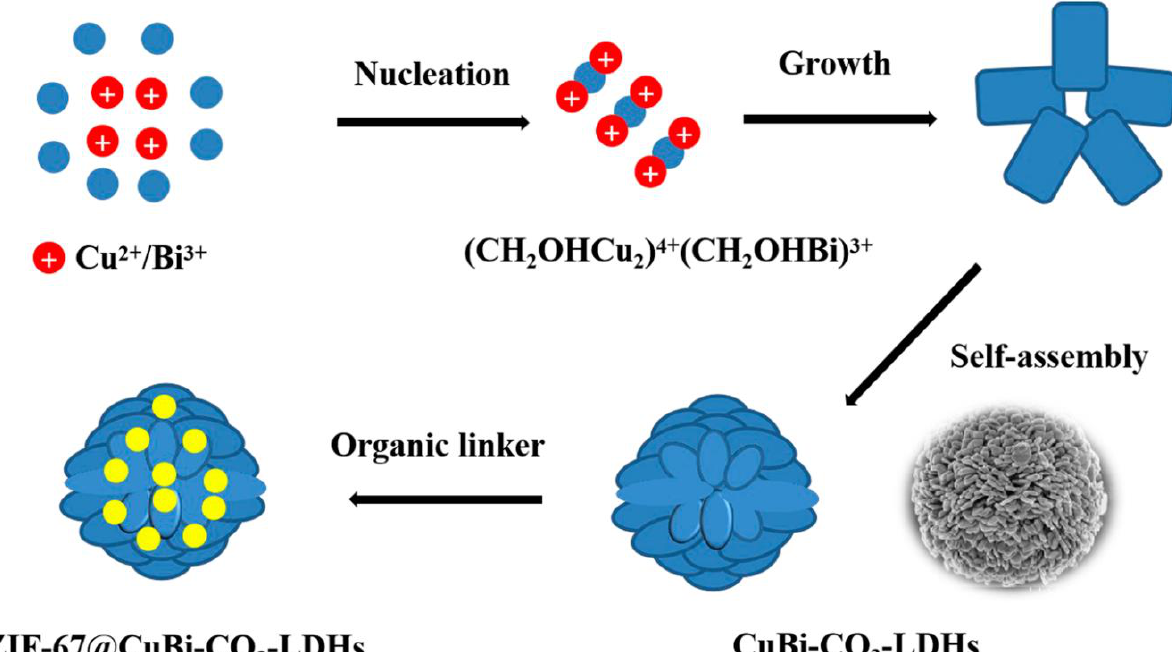
Figure 2. Schematic illustration for the formation of flower-like ZIF-67/CuBi–CO 3 -LDH, reproduced from [60] with permission, copyright The Materials Research Society, 2020.